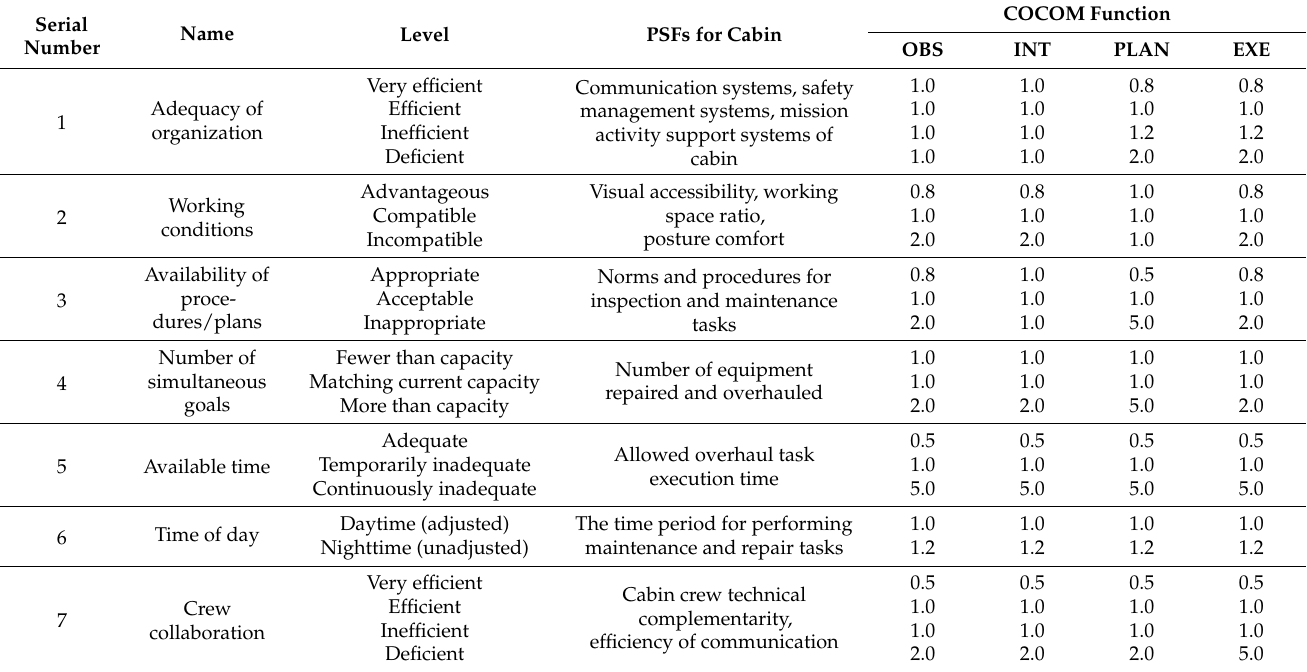
Table 3. CPCs and PSFs for cabin